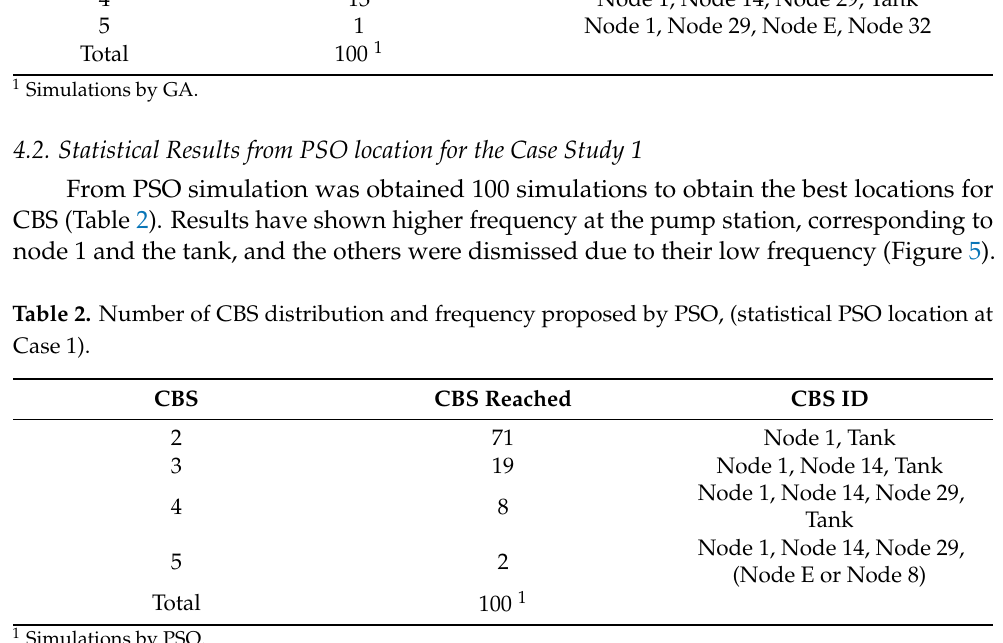
Table 1. Number of CBS distribution and frequency proposed by GA technique, (Statistical GA Lo- cation at Case 1).